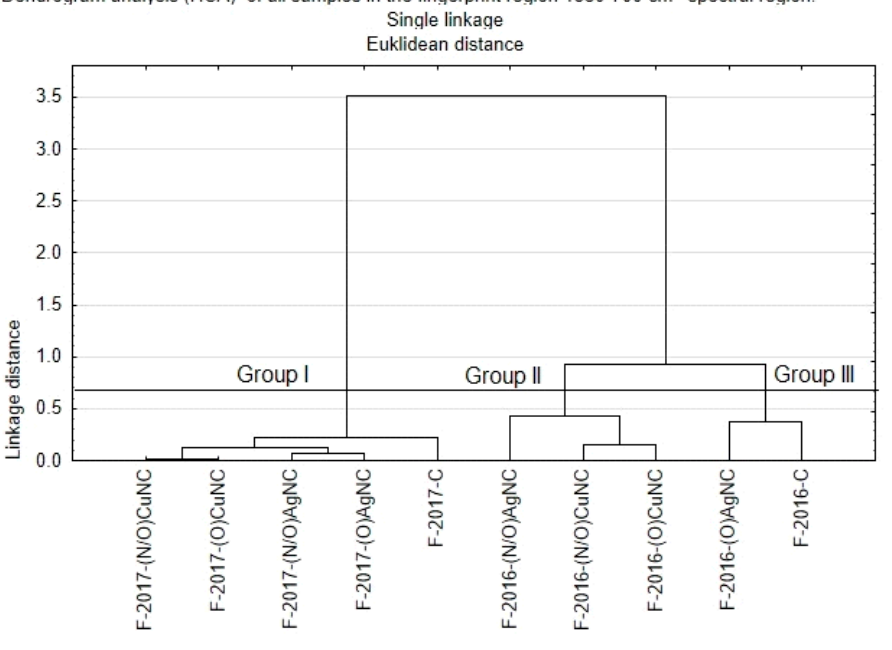
Figure 3. Hierarchical cluster dendrogram constructed from FTIR data for 10 oil samples. Table 5. The similarity of FTIR spectra of 10 oil